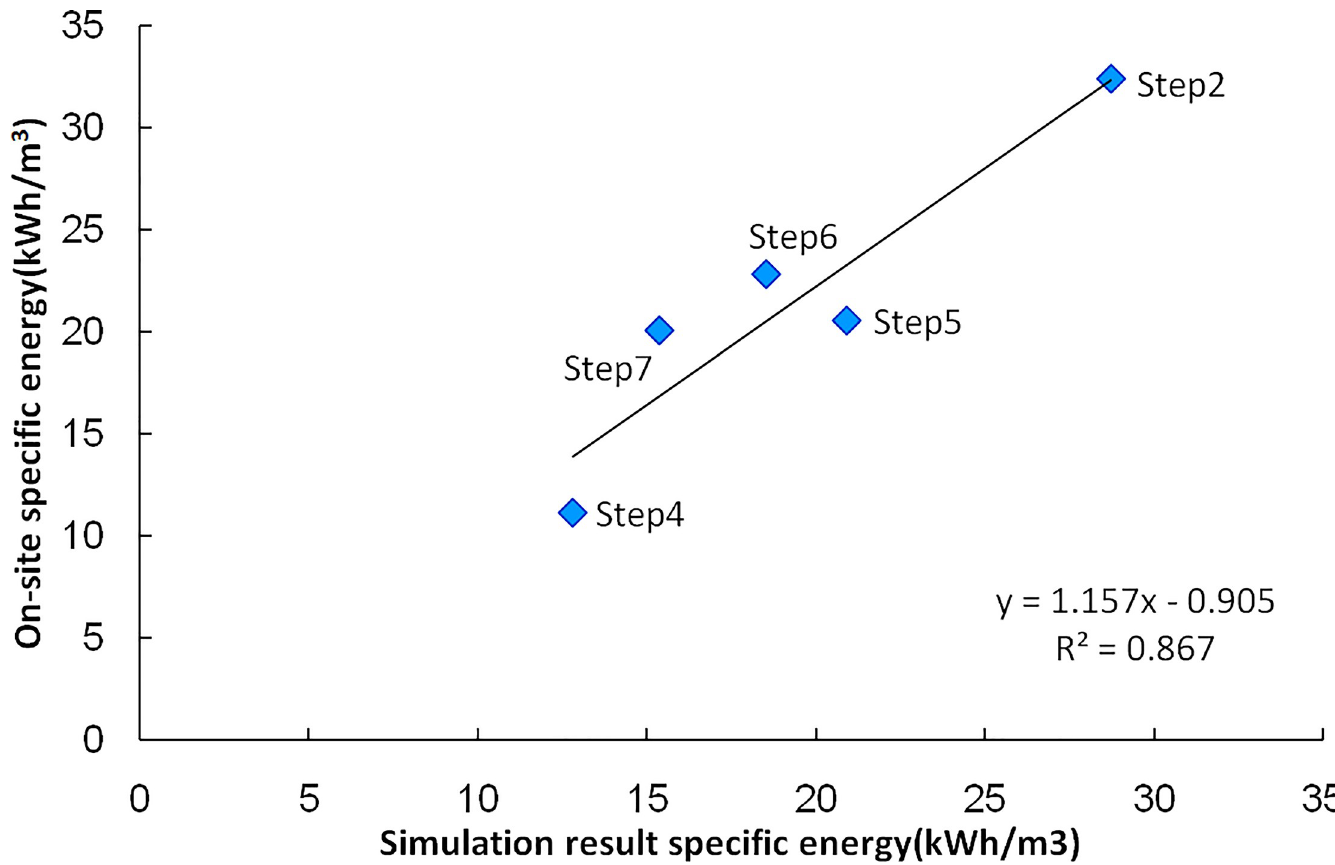
Fig 31. Specific energy relationship between on-site test and simulation